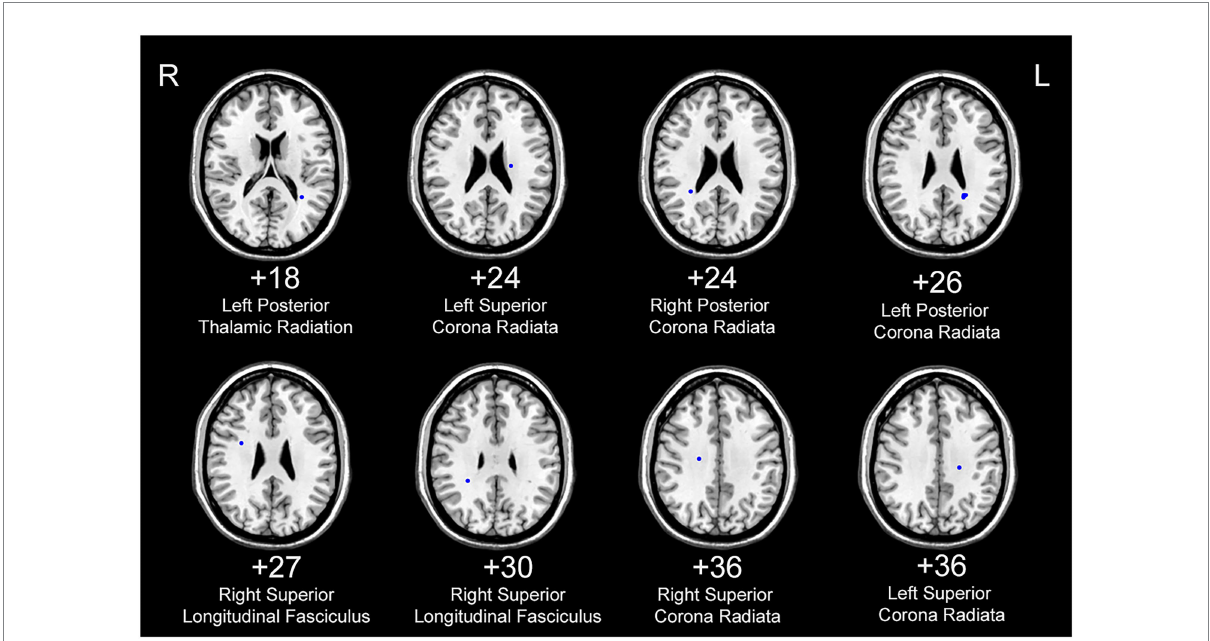
FIGURE 4 White matter areas with abnormal functional covariance connections. The areas marked in blue are the white matter areas, where the FCS is statistically different between the PD and HC groups (two sample T -test, p < 0.00005). The white figure depicts the cross-section level (Montreal Neurological Institute space). R: right side; L: left side. PD: Parkinsons’s disease, HC: healthy control.